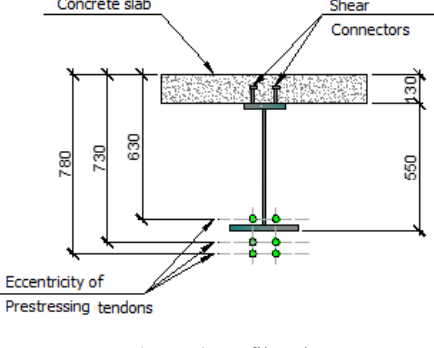
Figure 4. Profile